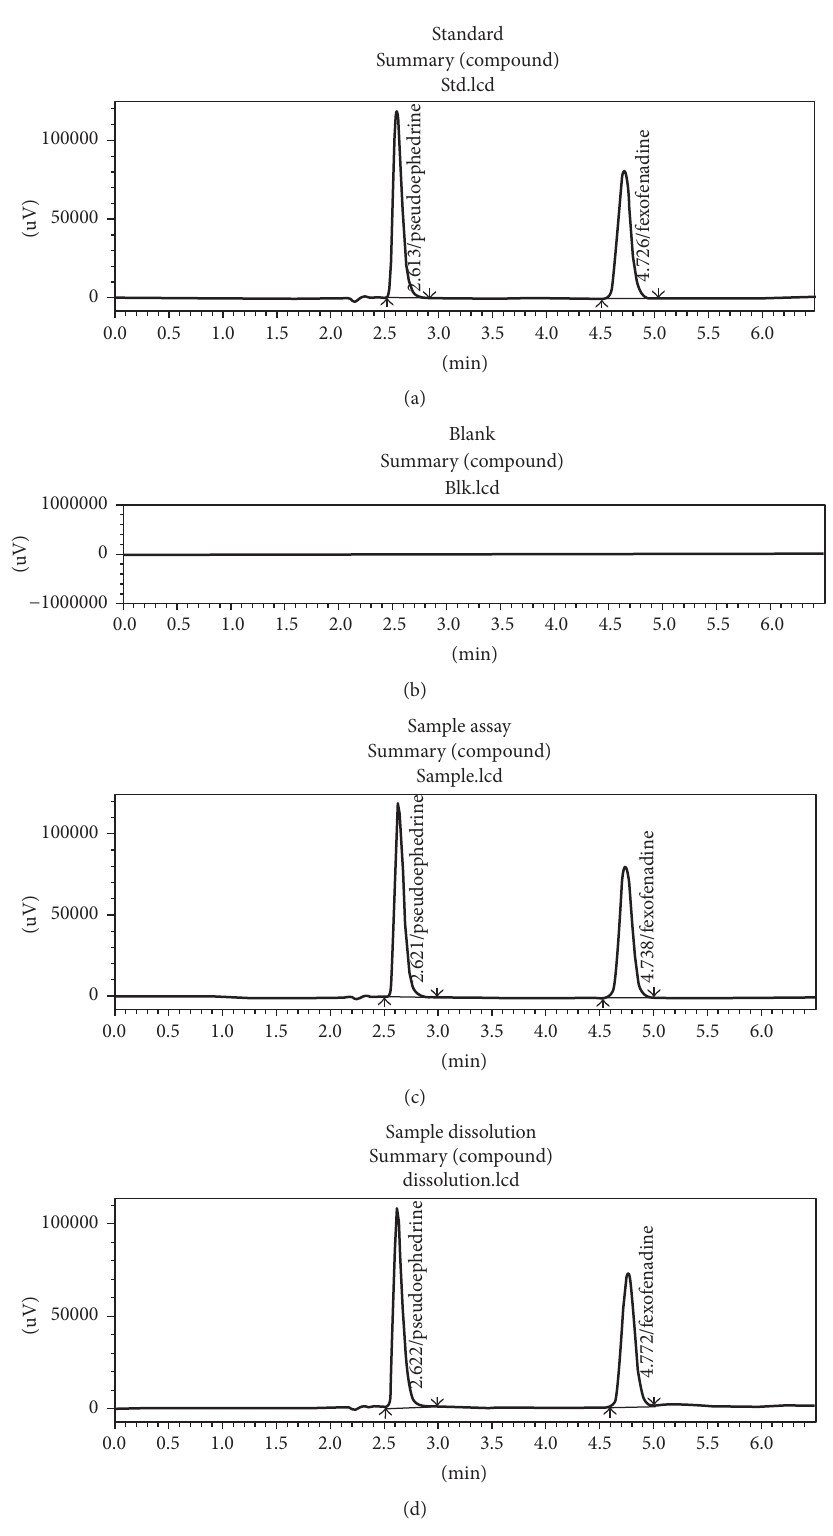
Figure 4: Chromatogram of (a) standard solution, (b) blank, (c) assay sample of tablet, and (d) dissolution